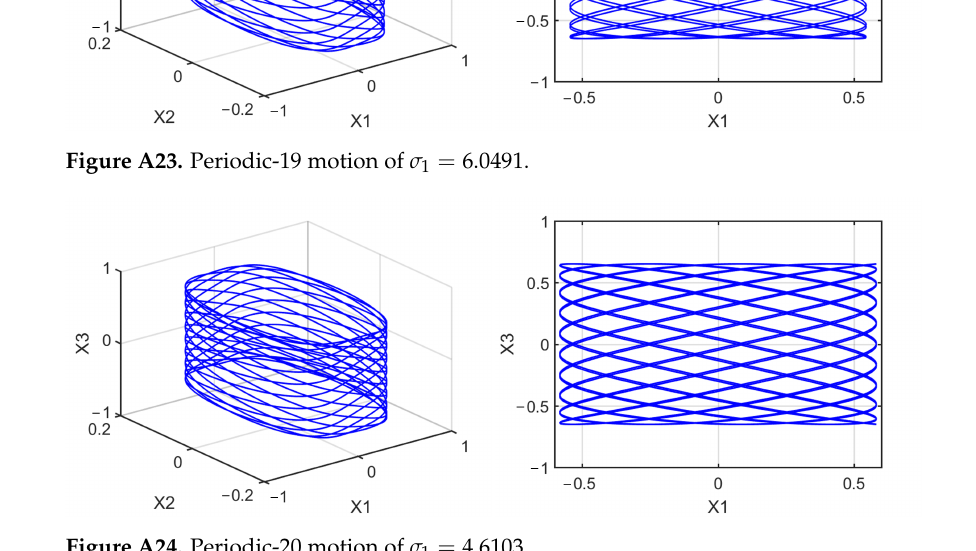
Figure A24. Periodic-20 motion of σ 1 = 4.6103.